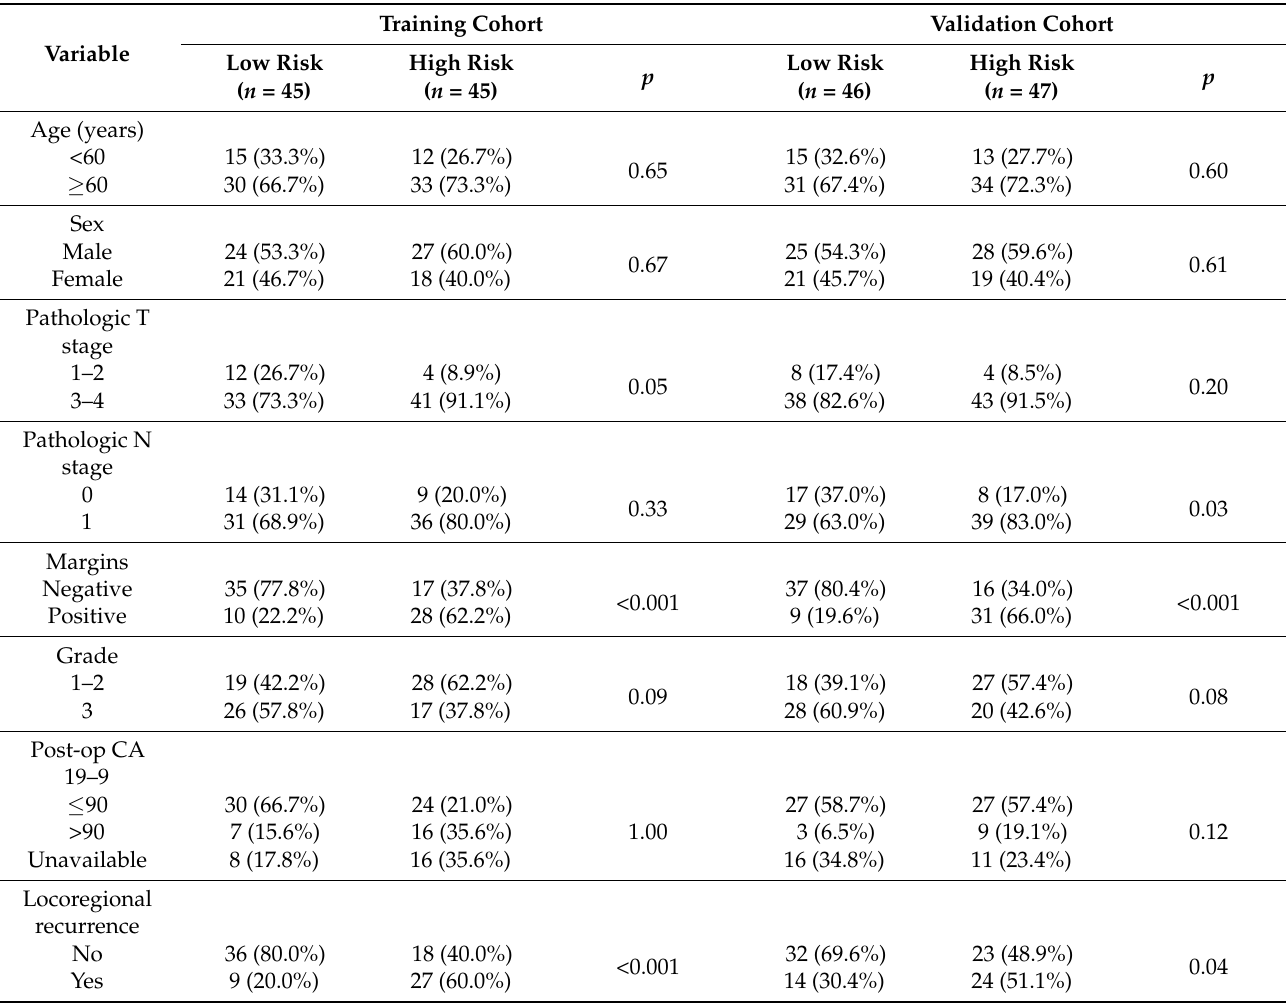
Table 1. Patient and disease characteristics of patients with resectable pancreatic cancer in the training and validation cohorts. Training Cohort Validation Variable